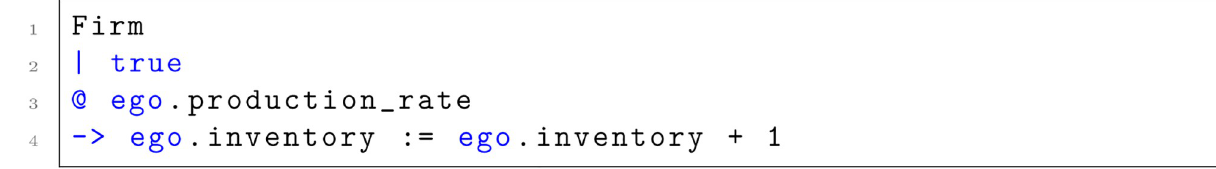
Fig 1. An example of a rule, modeling the production of a good at a certain